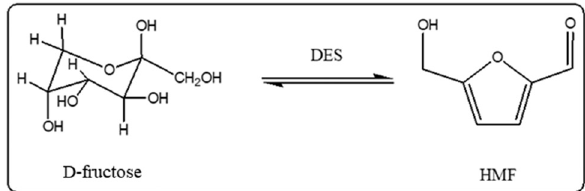
Figure 9: Conversion of fructose to 5-hydroxymethylfurfural (5HMF) catalyzed by DES.